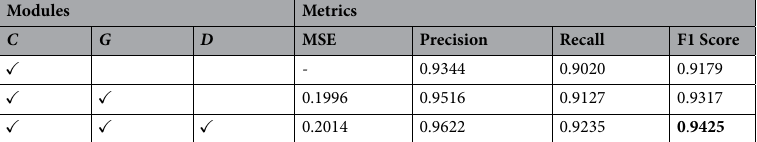
Table 2. Experimental results for ablation study on 0.5ds data. HG001 is the training data while HG002 is for testing. Since the LDV-Caller has extra submodules G and D than the Clair C , we made two experiments to validate the effectiveness of both G and D . The (cid:31) indicates whether the certain submodule is used. The first row is actually the Clair method while the last row is our LDV-Caller. MSE is used to evaluate submodule G while other metrics are used to evaluate the whole LDV-Caller. Significant value in